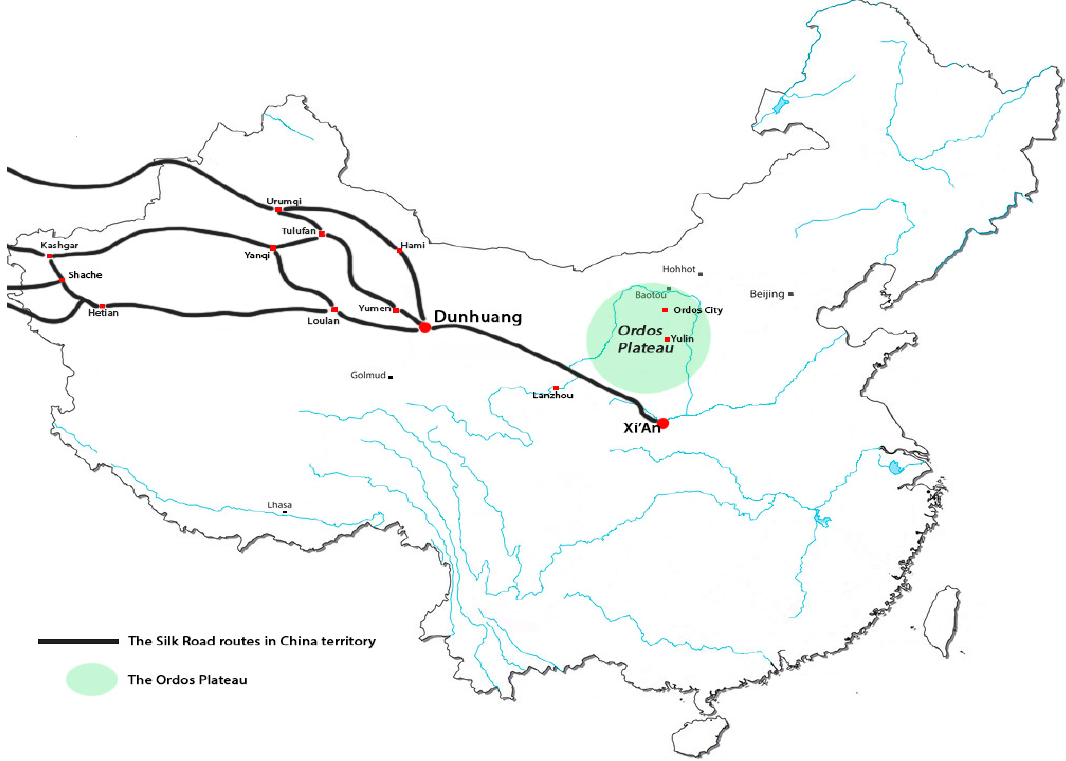
Map 1. The Ordos Plateau. Figure 1. The Ordos